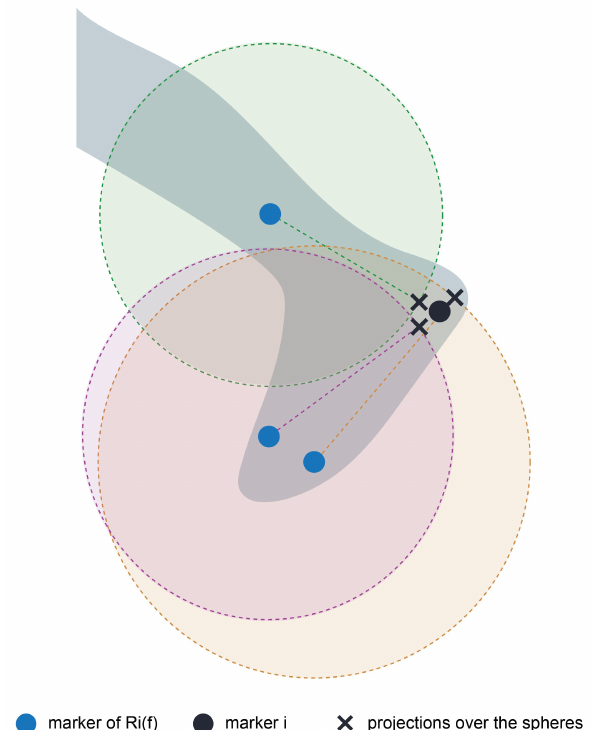
Figure 4. Example of an optimal point in the surroundings of the projections over the spheres centered in marker j ∈ R i ( f ) and with radius d ij ( f )